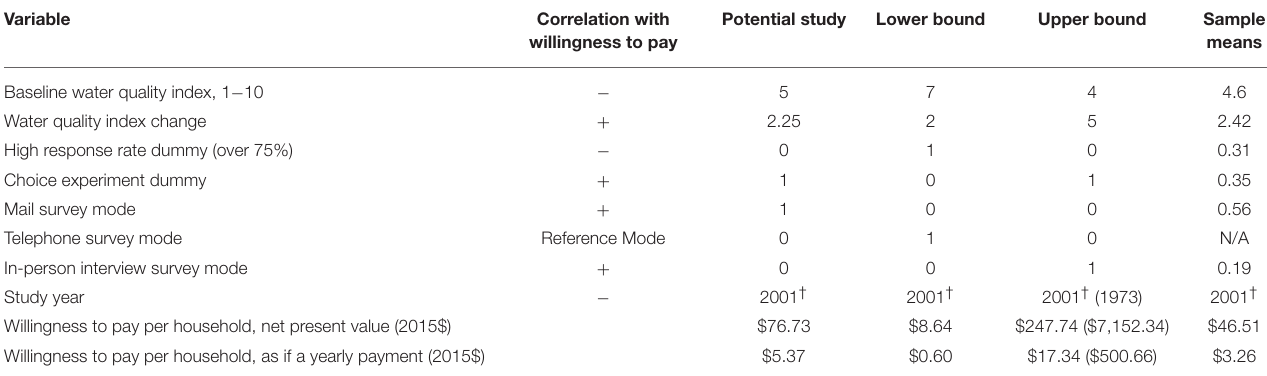
TABLE 2 | Meta-regression results applying Johnston et al. (2005).